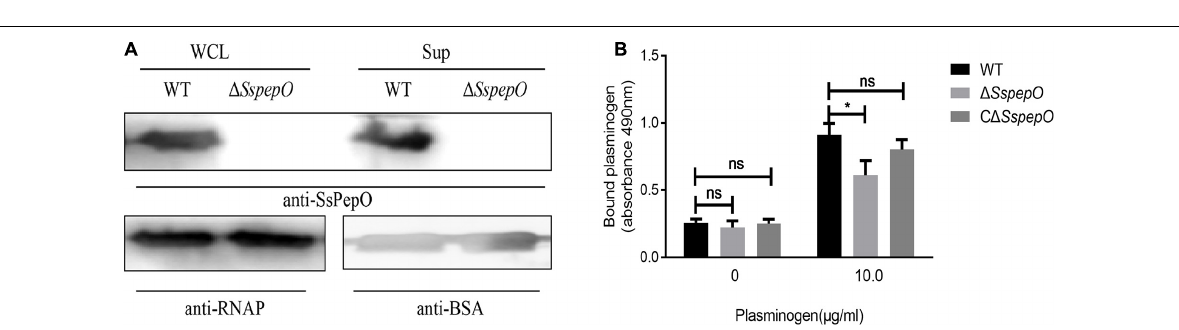
FIGURE 5 | Binding of bacteria to plasminogen. (A) Immunoblotting analysis of the SsPepO protein in culture supernatants and whole cell lysates. Bovine serum albumin (BSA) or RNA polymerase (RNAP) was used as the loading control for the supernatant or lysates, respectively. (B) Binding of plasminogen to S. suis . Microtiter plates were coated with S. suis wild-type (WT), SspepO mutant, or C (cid:49) SspepO strains, and the binding of plasminogen (0 and 10 µ g/ml) was assessed. Bound plasminogen was detected using specific polyclonal Abs. The assay was repeated three times, and the data was represented as the mean ± SD. ns, not significant; * p <